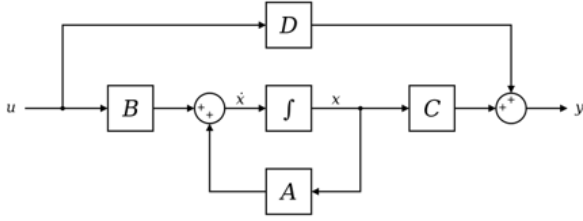
Figure 1. Graphical representation of the state-space